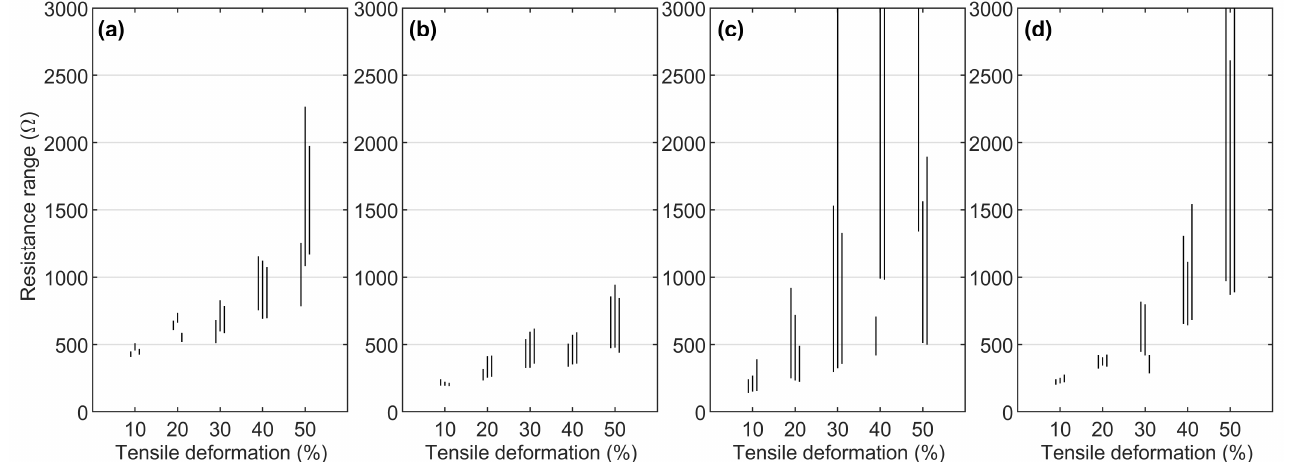
Figure 7. Resistance range lines of cyclic sample series, where three parallel samples are grouped together. The bottom and top endpoints of the lines show the minimum and maximum resistance values of the samples: ( a ) series with 1 thin CFC, ( b ) series with 2 thin CFCs, ( c ) series with 3 thin CFCs, and ( d ) series with 1 thick CFC.